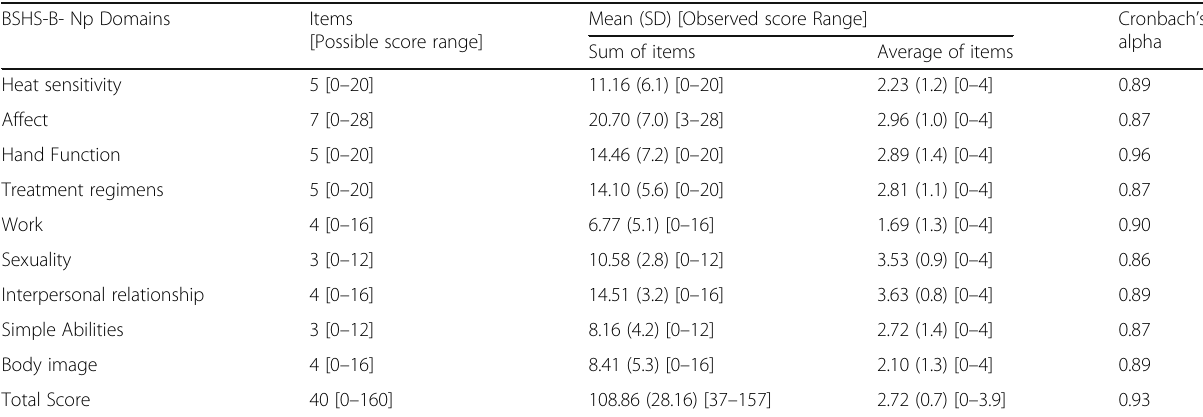
Table 2 Means Standard deviation and Internal Consistency of BSHS-B- Np BSHS-B- Np Domains